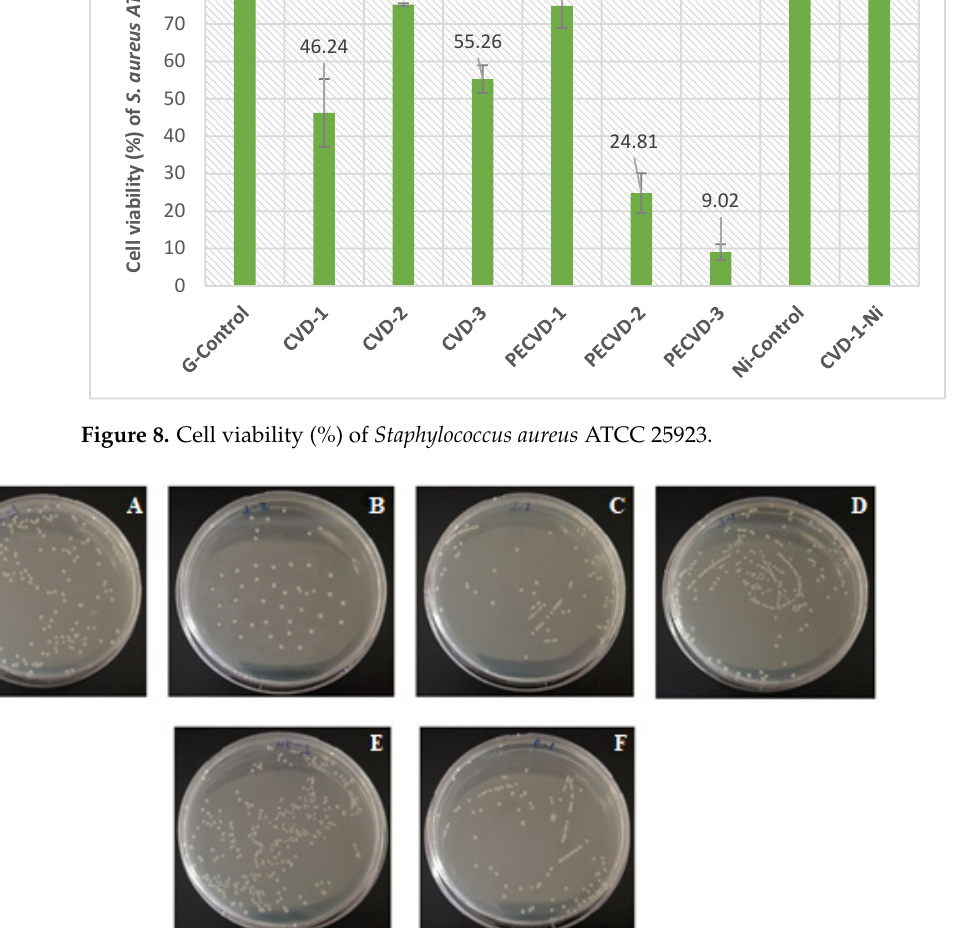
Figure 9. Antibacterial activity of Escherichia coli ATCC 35218 (( A ) glass control; ( B ) CVD-1; ( C ) CVD-2; ( D ) CVD-3; ( E ) Ni Control; ( F ) CVD-1-Ni).